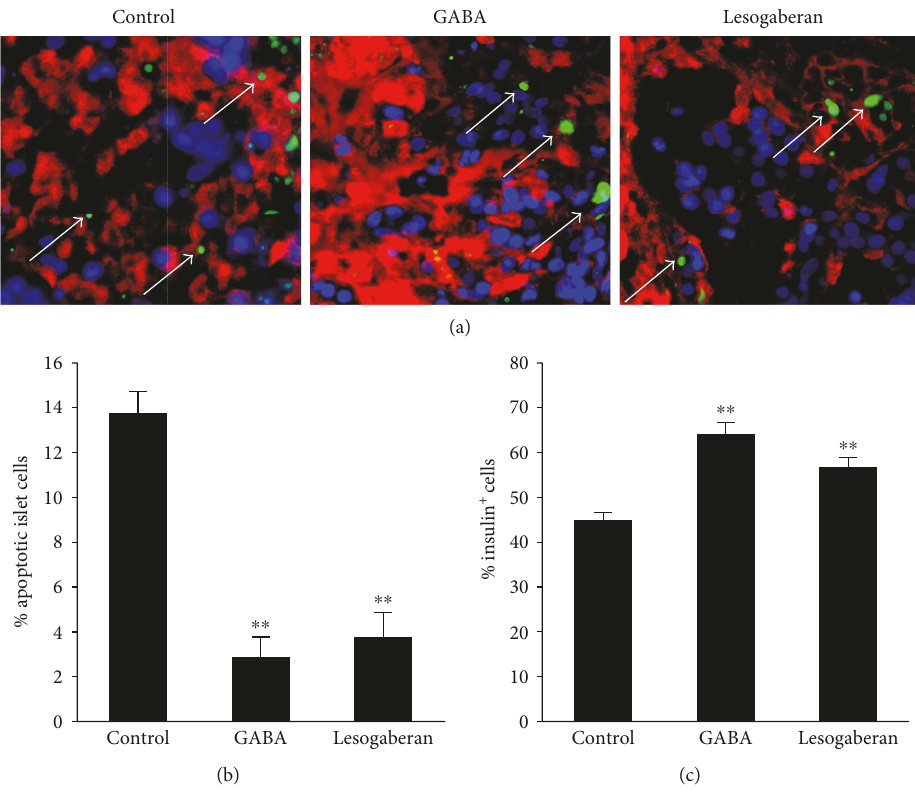
Figure 3: Oral lesogaberan protects human islet β -cells from apoptosis in islet grafts in mice. Diabetic NOD/scid mice were implanted with human islets and treated with plain water or water containing lesogaberan (0.08 mg/ml) or GABA (6 mg/ml) for 48h. The percentages of apoptotic islet cells and islet β -cells in total human islet cells were determined by TUNEL assay and costaining with anti-insulin as well as DAPI. At least 2000 human islet cells in 10 fi elds (magni fi cation × 400) from individual grafts were counted. Data are representative image or expressed as the mean % ± SEM for each group of mice ( n = 5 − 7 ) from three separate experiments.(a) A representative image with white arrows indicating TUNEL + cells (green for TUNEL + , red for anti-insulin + , and light blue for DAPI staining). (b) Percent apoptotic islet cells and (c) percent insulin + islet cells. ∗∗ p < 0 01 versus the